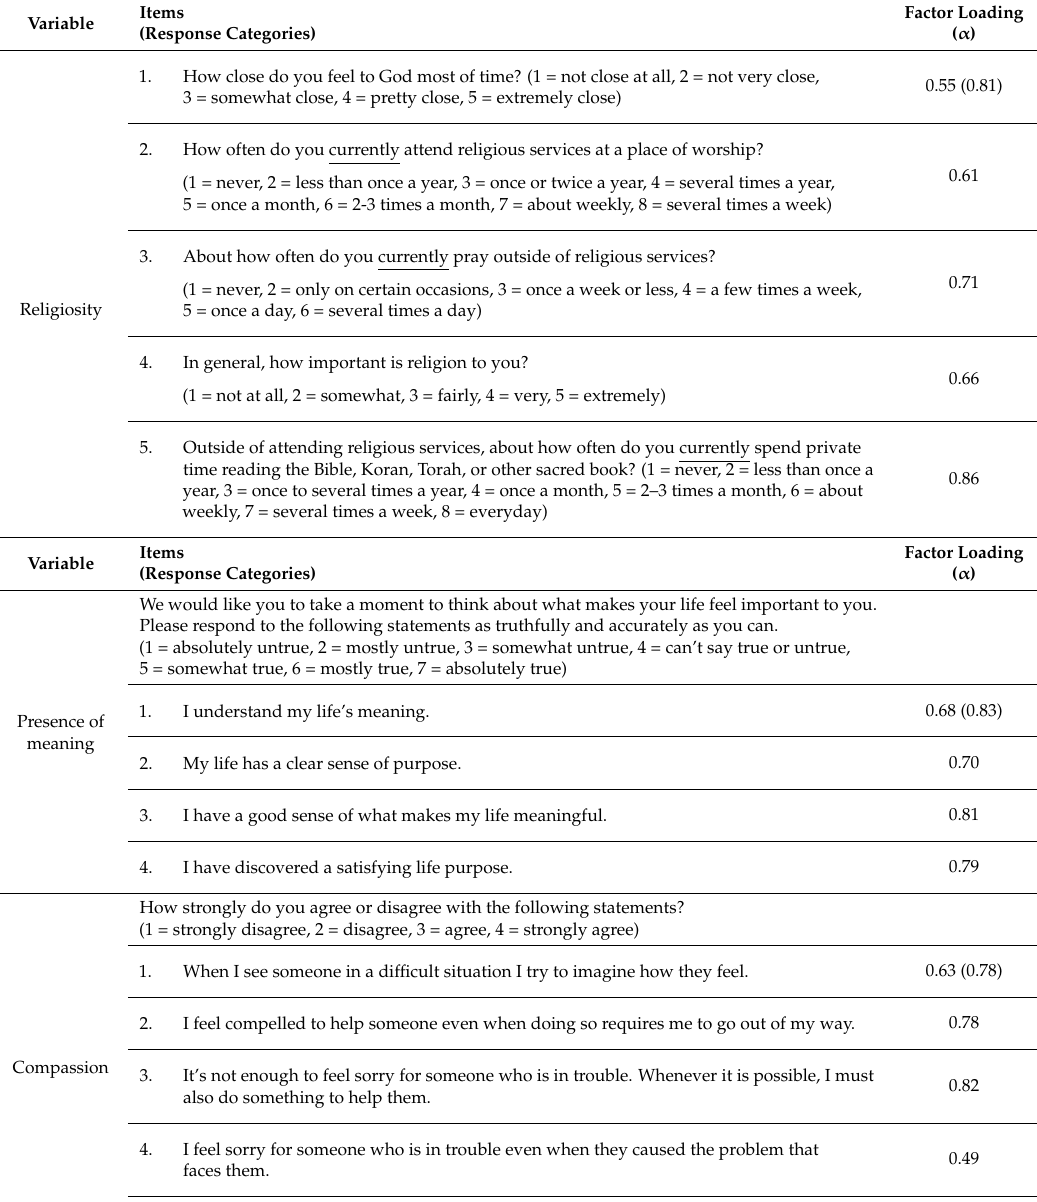
Table A1. Variables Used in